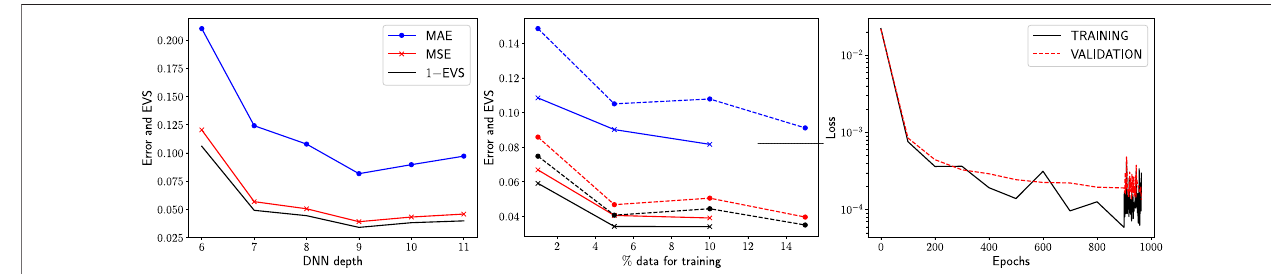
FIGURE4| Errorscalculatedonthedataset TEST _ AVG areplottedfordifferentDNNmodels,withvariousdepthontheleft,andvarioussizesoftrainingdataseton the middle. On the left, models are trained on 10 % of the data, meaning around 230,000 data. On the middle, dot lines with circles are for a model of depth 8, and continuous lines with crosses for a model of depth 9. In blue, we plot the Mean Average Error, in red the Mean Square Error, and in black one minus the Explained VarianceScore.Ontheright,thelossfunction(MSE)isplottedduringthetraining,evaluatedonthetrainingdataset,andonthevalidationdataset.Weseeattheend that we make more often evaluations of these errors, and the training stops selecting the more accurate model in the last epochs. Note that this loss may not be compared with anything in this article, as it is given on scaled